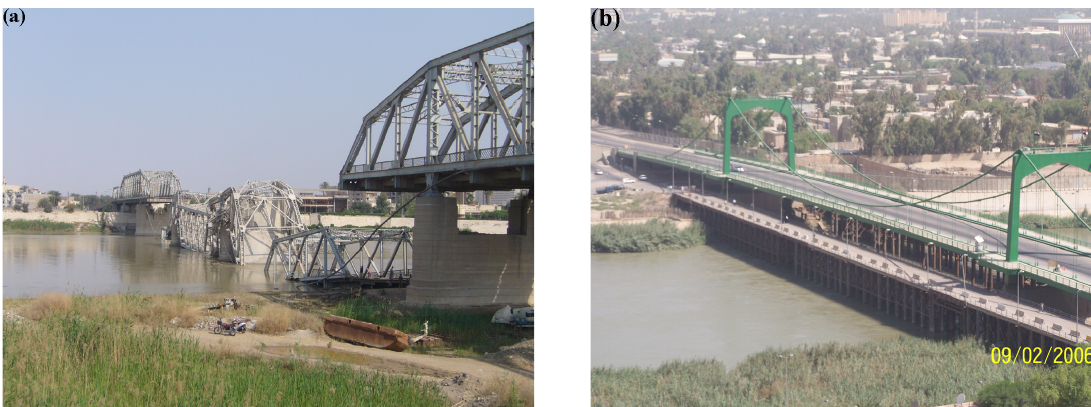
Fig. 5. (a) Destroyed parts from Al-Sarafia Bridge have fallen in the river (available at: www.wikipedia.org). (b) Temporary bridges parallel to the suspended bridge.